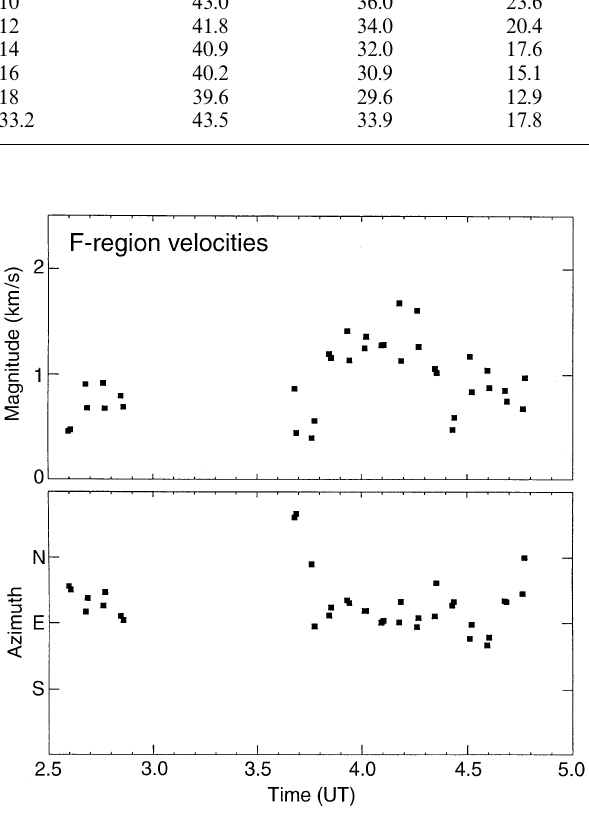
Fig. 6. Magnitude and direction of F-region velocity during the experiment.Integration time was 45 s, and the parallel component of velocity was set